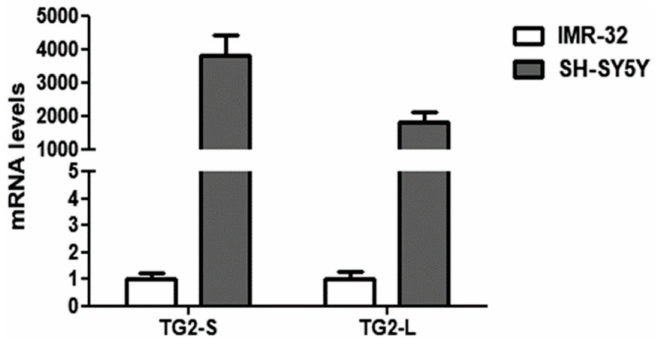
Figure 2. Comparison of basal transcript levels of the two TG2 isoforms, TG2-L and TG2-S, between SH-SY5Y and IMR-32 NB cells cultured in normal O 2 conditions. The relative mRNA levels of TG2-L and TG2-S in SH-SY5Y are expressed as fold changes in comparison to IMR-32 cells. Data are expressed as mean ±